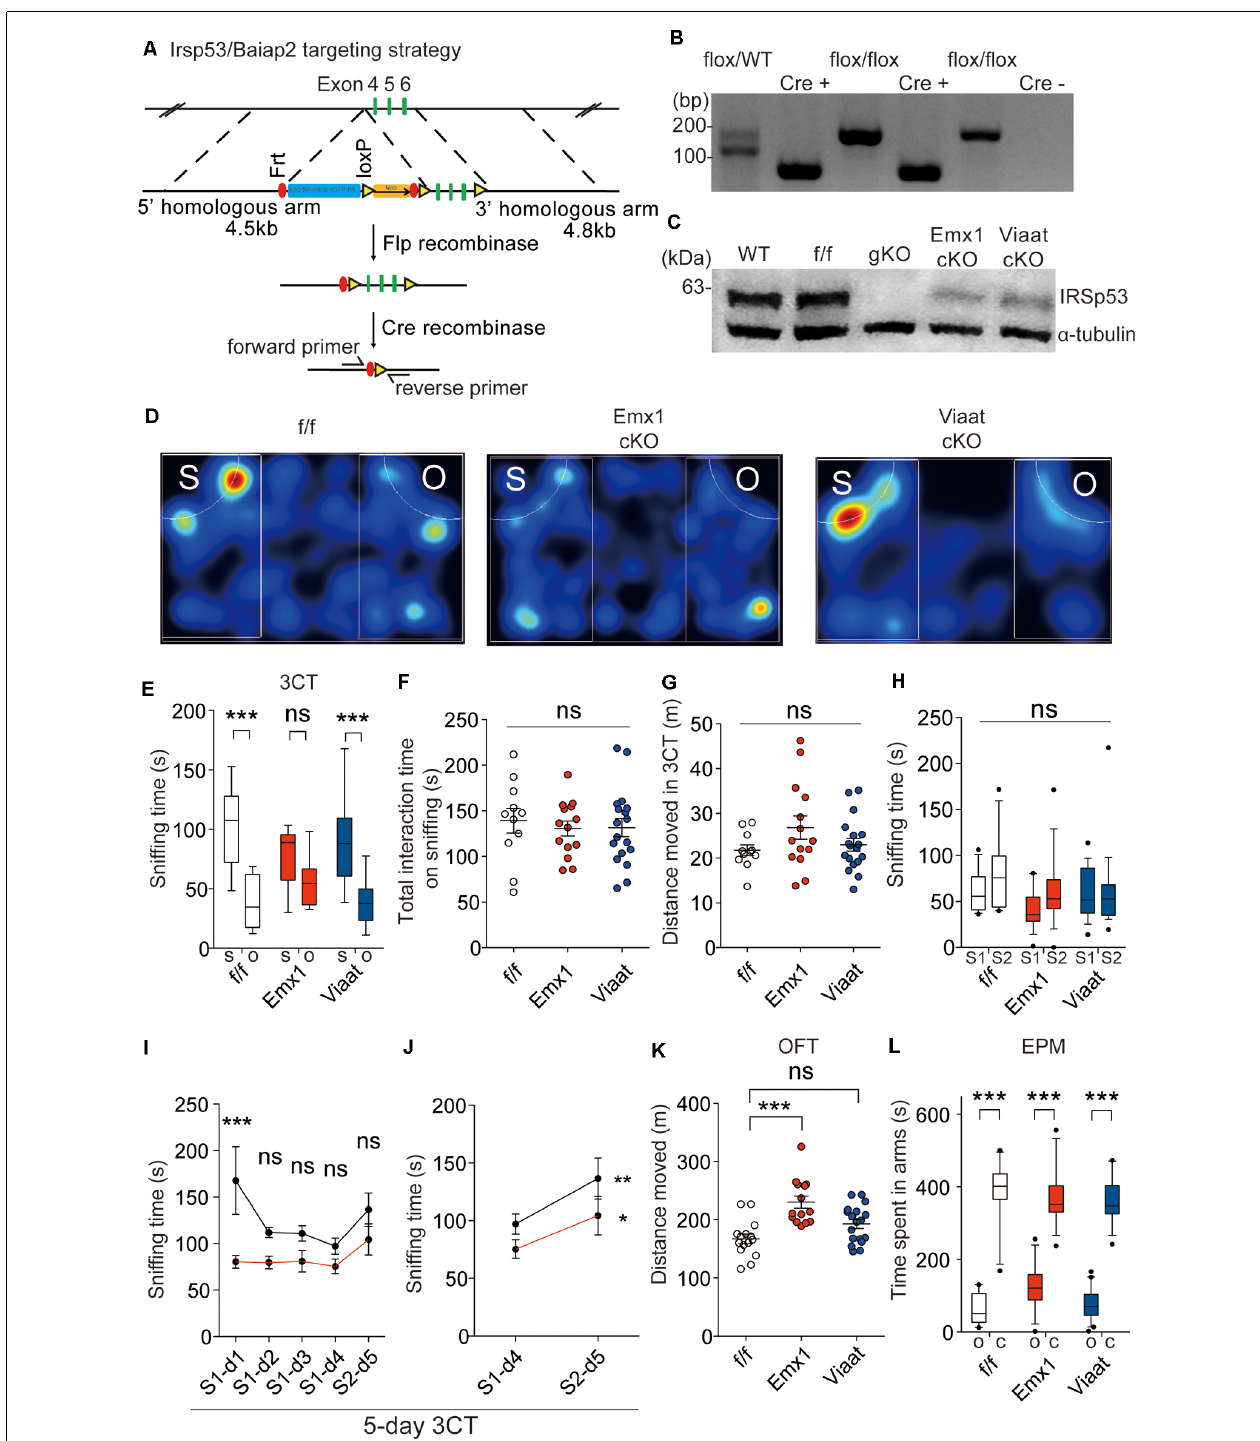
FIGURE 2 | Irsp53 deletion in glutamatergic but not GABAergic neurons induces social deficits and hyperactivity. (A) Schematic for conditional Irsp53/Baiap2 knockout (KO). (B) Polymerase chain reaction (PCR) genotyping of Irsp53 fl / fl mice and conditional Irsp53 -KO mice ( Emx1-Cre;Irsp53 fl / fl or Viaat-Cre;Irsp53 fl / fl mice) using primer sets directed for the Irsp53/Baiap2 allele and Cre recombinase. The two bands in the WT/flox lane represent PCR products from Irsp53 alleles with and without the Frt + LoxP sites. (C) Levels of IRSp53 proteins in global IRSp53-KO (gKO) mice, Emx1-Cre;Irsp53 fl / fl mice (Emx1 cKO), and Viaat-Cre;Irsp53 fl / fl mice (Viaat cKO). Whole-brain lysates from mice at P56 were used for immunoblotting. (D–G) Suppressed social interaction in Emx1-Cre;Irsp53 fl / fl but not